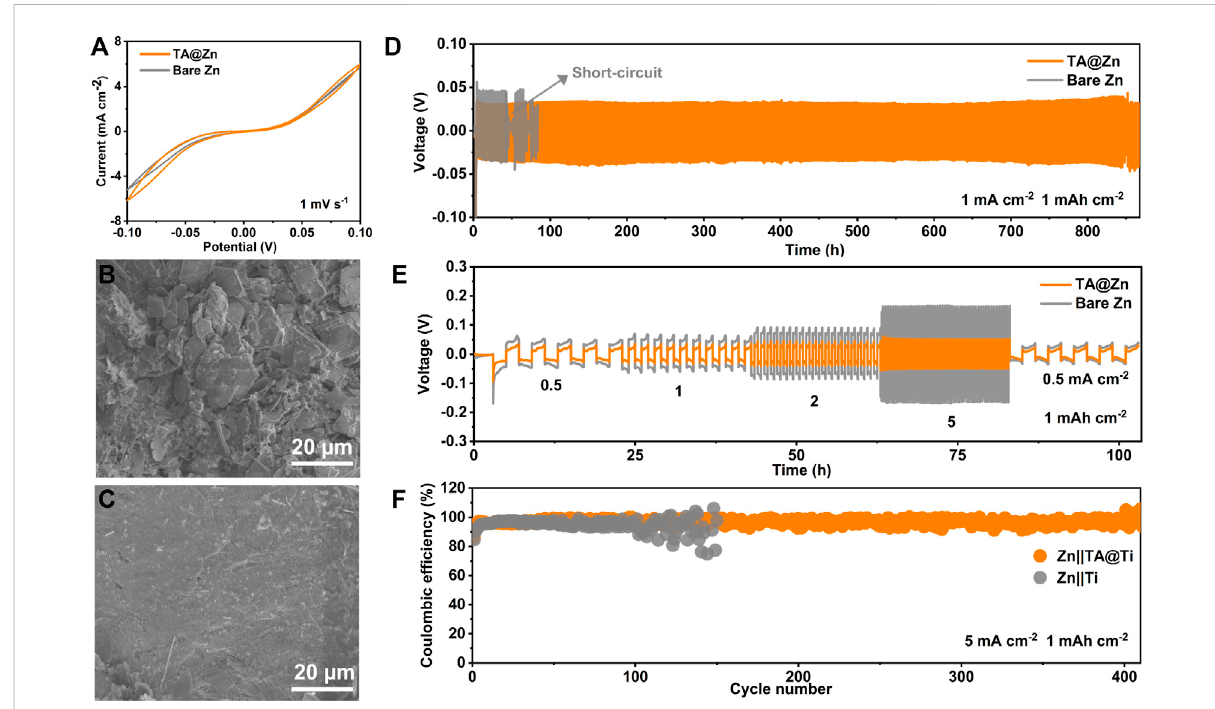
FIGURE 2 ElectrochemicalperformanceandcharacterizationsofZnsymmetriccells. (A) cyclicvoltammetry(CV)curvesoftheZnsymmetriccellsat1 mV s − 1 . SEM images of (B) bare Zn and (C) TA@Zn after cycled at 1 mA cm − 2 , 1 mAh cm − 2 . (D) long-term stability of Zn symmetric cells at 1 mA cm − 2 , 1 mAh cm − 2 . (E) rateperformance ofsymmetric cellswith alimitedareal capacityof 1 mAhcm − 2 . (F) Coulombic ef fi ciency oftheZn|TiandZn| TA@Ti cells at 5 mA cm − 2 , 1 mAh cm − 2